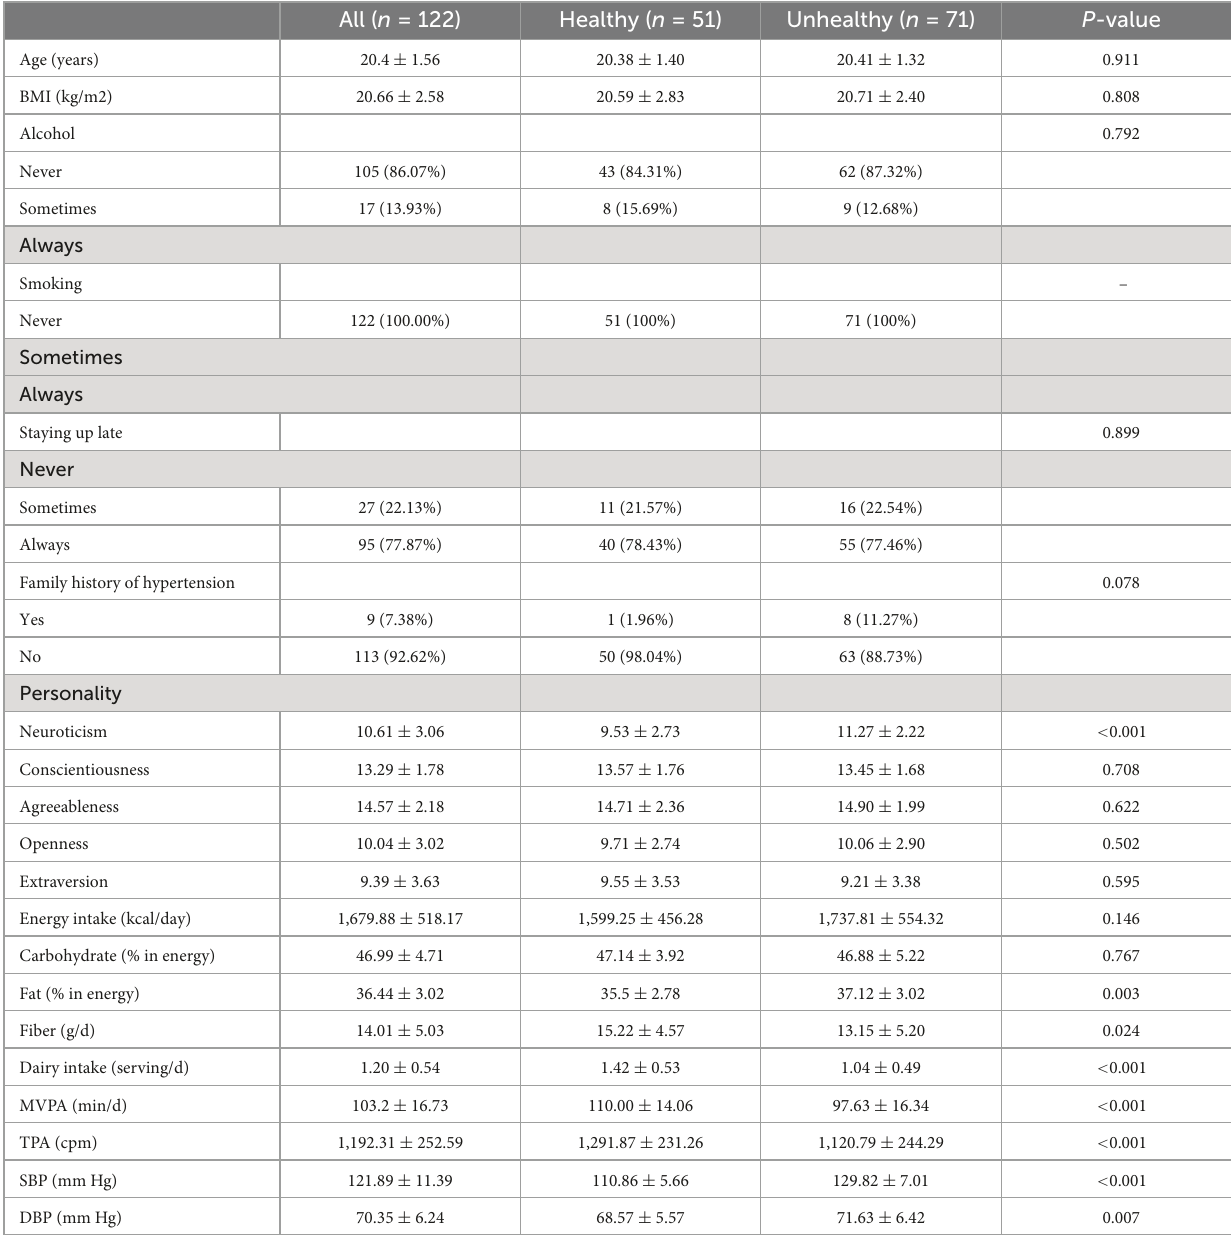
TABLE 2 Characteristics of participants with healthy or unhealthy blood